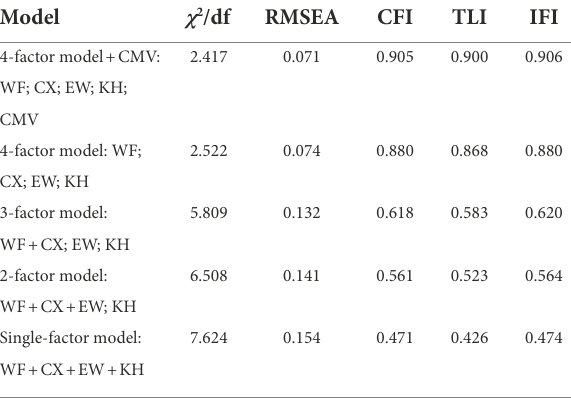
TABLE 1 The results of confirmative factor analysis.